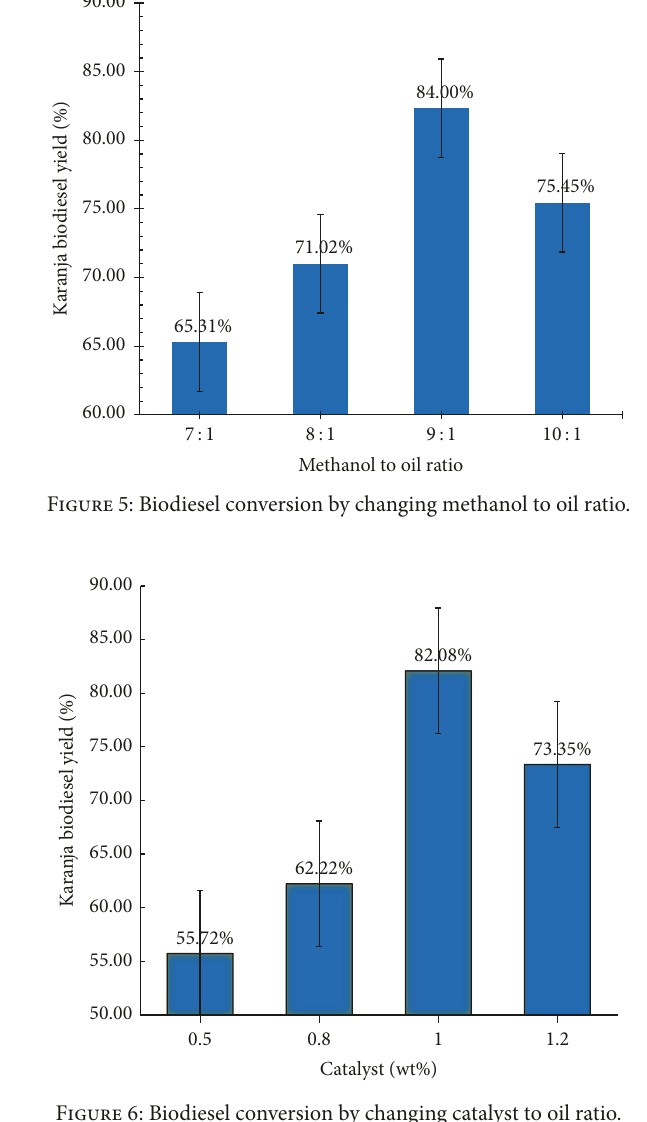
Figure 6: Biodiesel conversion by changing catalyst to oil